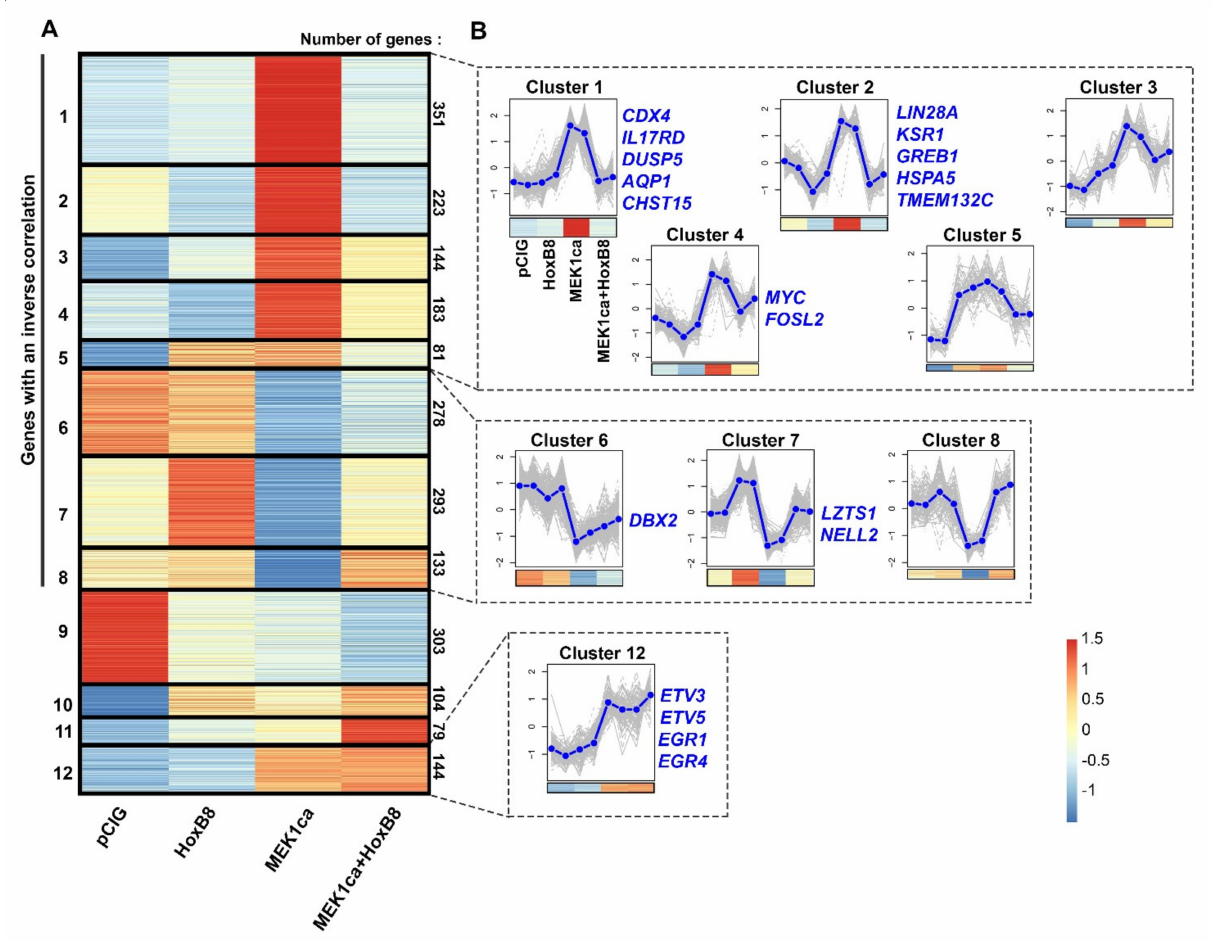
Figure 3. Clustering of genes deregulated by MEK1ca. ( A ) Heat map ( z -scores derived from TPM values) of the 2316 genes deregulated in the “MEK1ca versus PCIG” condition (FDR5) clustered using k -means with k = 12 for the pCIG, HOXB8, MEK1ca and MEK1ca + HOXB8 conditions. 1686 genes (72.8%, clusters 1–8) display an inverse correlation between the “MEK1ca versus pCIG” and “MEK1ca + HOXB8 versus MEK1ca” conditions. Only 144 genes (6.2%, cluster 12) behave the same in the MEK1ca and MEK1ca + HOXB8 conditions (i.e., are not reversed by HOXB8). ( B ) Plots of clusters 1–8 and 12 with two replicates of each condition (control (pCIG1, pCIG2), HOXB8 (HOXB8-1 and HOXB8-2), MEK1ca (MEK1ca-1 and MEK1ca-2) and MEK1ca + HOXB8 (MEK1ca + HOXB8-1 and MEK1ca + HOXB8-2)), with the mean (in blue) and with the corresponding heat map in the bottom. Some representative genes of the clusters are on the right side of the corresponding